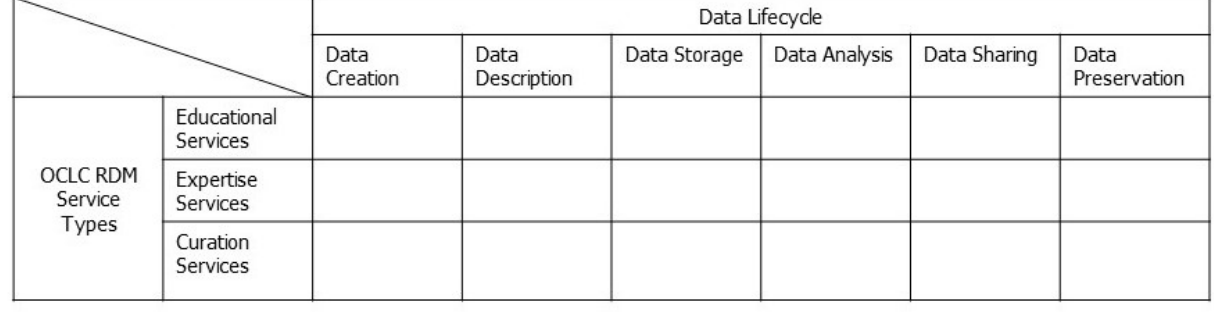
aligned with the categories of the interview